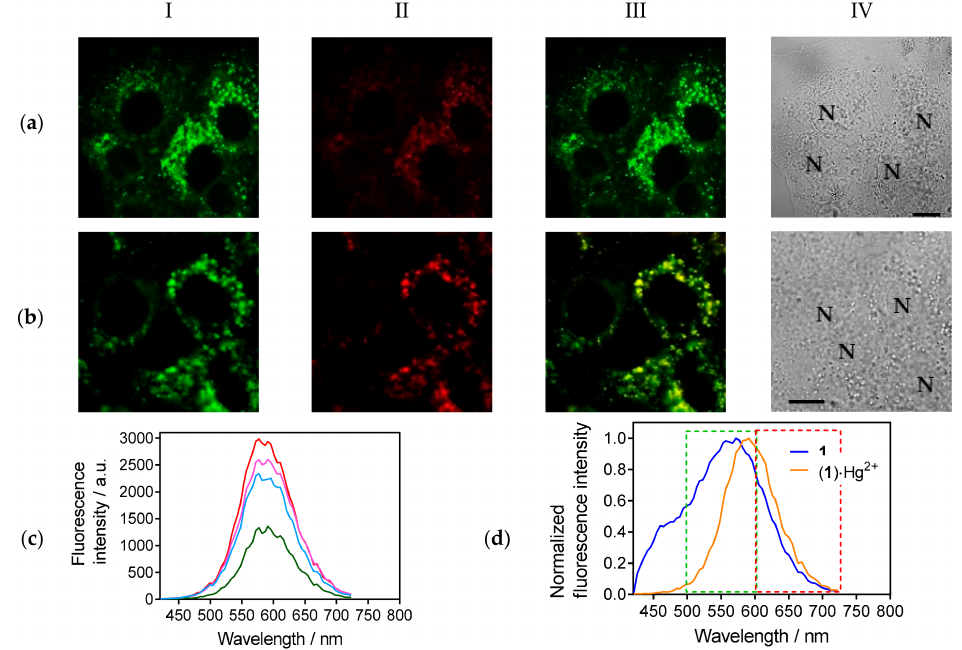
Figure 4. Confocal fluorescence images ( a , b ) and fluorescence spectra ( c , d ) of 1 and ( 1 ) · Hg 2+ in A549 cells. (Row a ) Cells were incubated with 1 (10 µ M) for 20 min. (Row b ) Cells were pre-incubated with 20 µ M Hg(ClO 4 ) 2 for 15 min, washed twice with Hanks’ solution, and incubated with 1 (10 µ M) for 20 min. Images of intracellular fluorescence were measured in the 500–600 nm (column I) and 600–730 nm (column II) spectral ranges at λ ex = 405 nm. Merged fluorescent images are shown in column III. Transmitted light images of cells are shown in column IV. Bar represents 10 µ m. N marks a nucleus. ( c ) Fluorescence spectra of 1 from different regions of cells pre-incubated with Hg(ClO 4 ) 2 . ( d ) Typical normalized intracellular fluorescence spectra of 1 and ( 1 ) · Hg 2+ . Green and red rectangles show two spectral regions (500–600 and 600–730 nm) selected for acquisition of images shown in columns I and